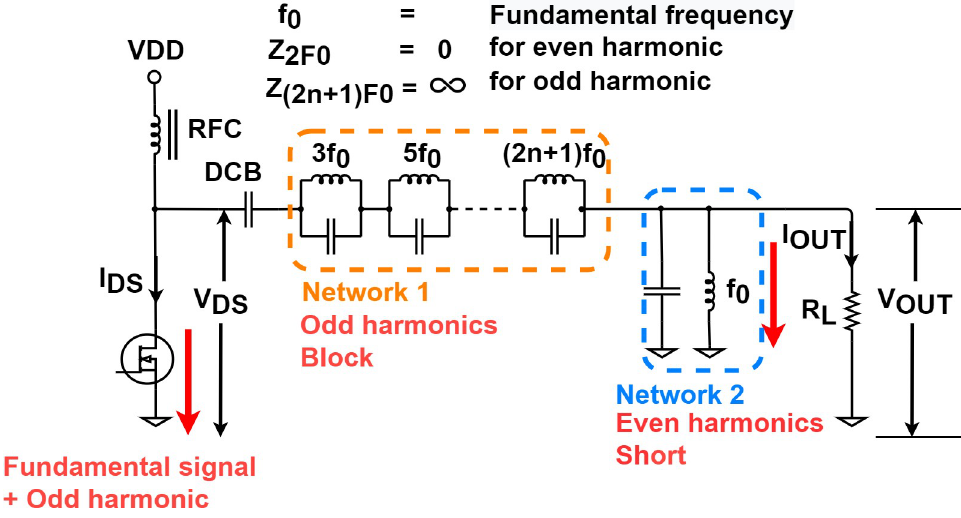
PLOS ONE | https://doi.org/10.1371/journal.pone.0249034 March 29,